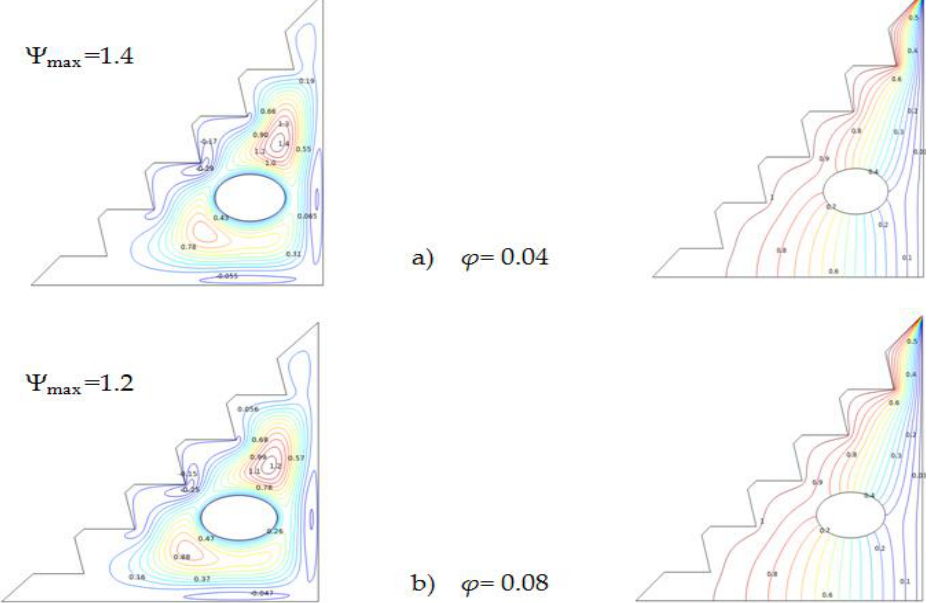
Figure 4. Average Nu for Ra = 10 5 , Ha = 0, and w = 0.